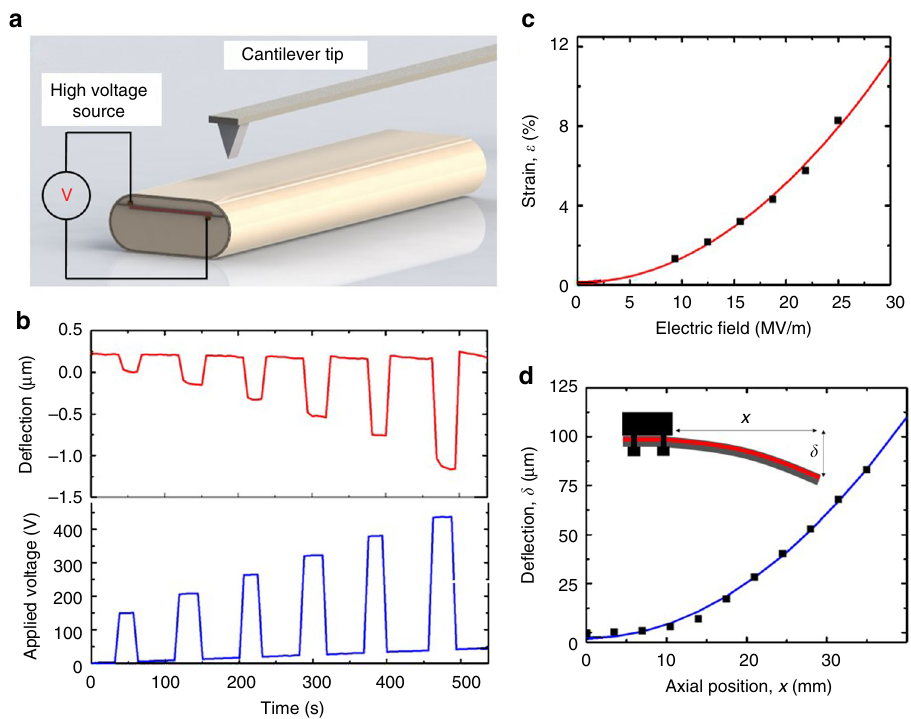
Fig. 2 Characterization of electrostrictive fi bres. a Experimental set-up for HVAFM and contact pro fi lometer measurements. b AFM cantilever tip displacement at the surface of the fi bre under increasing voltage. c Electrostrictive strain in the fi bre calculated from tip displacement and applied electric fi eld in the terpolymer layer. The solid red line is a second order fi t for the measured data and well-agreed with the electrostriction principle (i.e., quadratic dependence of strain to the applied electric fi eld). d Contact pro fi lometry measurement of fi xed-end fi bre de fl ection at 200 V. The solid blue line is a quadratic fi t for the measured data and agreed with the beam de fl ection case (i.e., quadratic dependence of de fl ection to the fi bre length) where